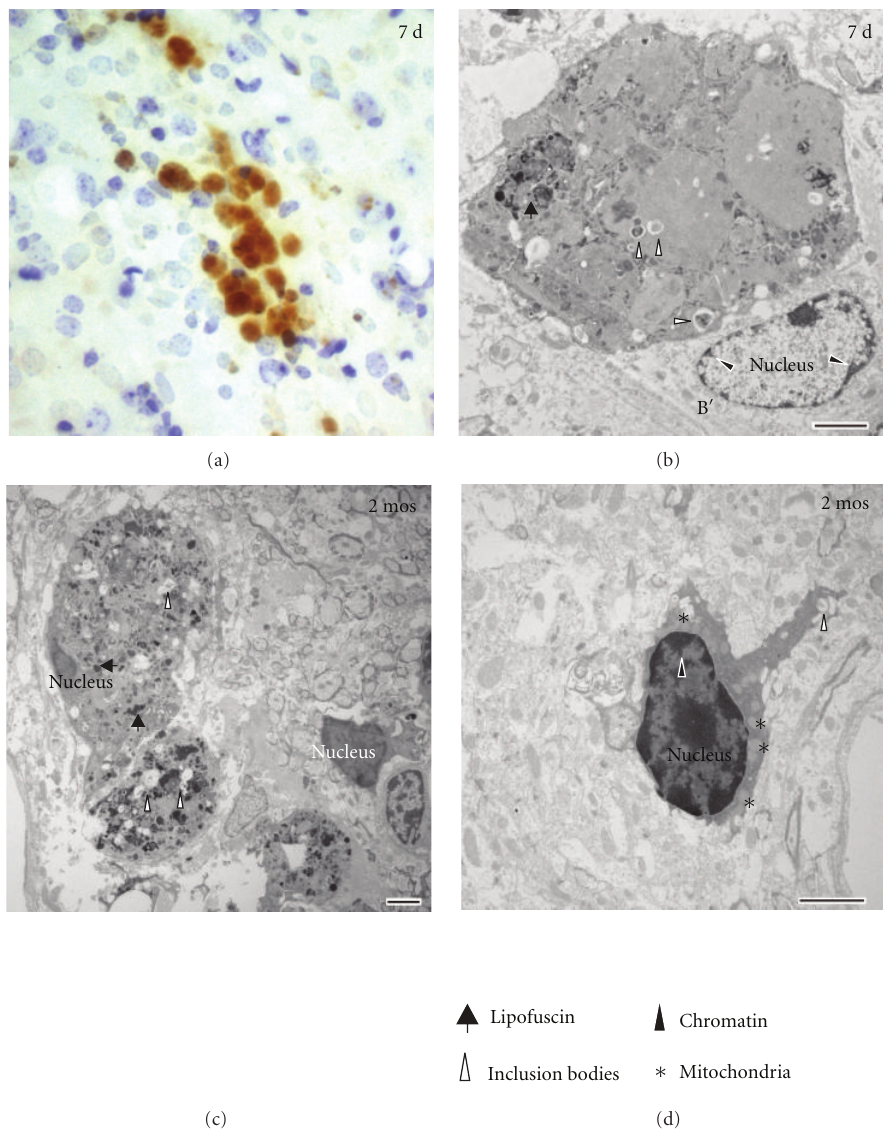
Figure 5: Ultrastructural analysis of striatal tissue from mice intranasally administered MSC-EGFPs. (a) Representative example of light microscopy image of DAB-stained tissue in striatum. (b) Characteristic structure observed in striatum of mice at 7 days after MSC- EGFP treatment. Darkened cell-like structures have few if any discernable organelles but are full of inclusion bodies, lipofuscin, and other degenerated products. A healthy nucleus and cell can be seen in the lower right portion of the panel (B (cid:3) ). 2 months after MSC-EGFP treatment, similar darkened structures were detected (c) as well as darkened cells with pyknotic nuclei, shrunken cytoplasm, and vacuoles (c) and (d). Scale bar is 2 μ